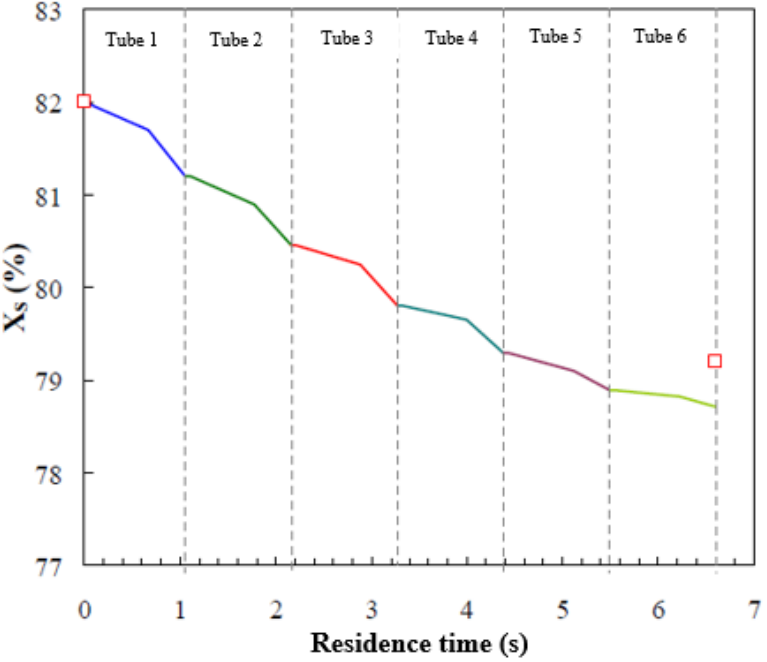
Figure 8. Concentration profile of the solution film versus residence time.